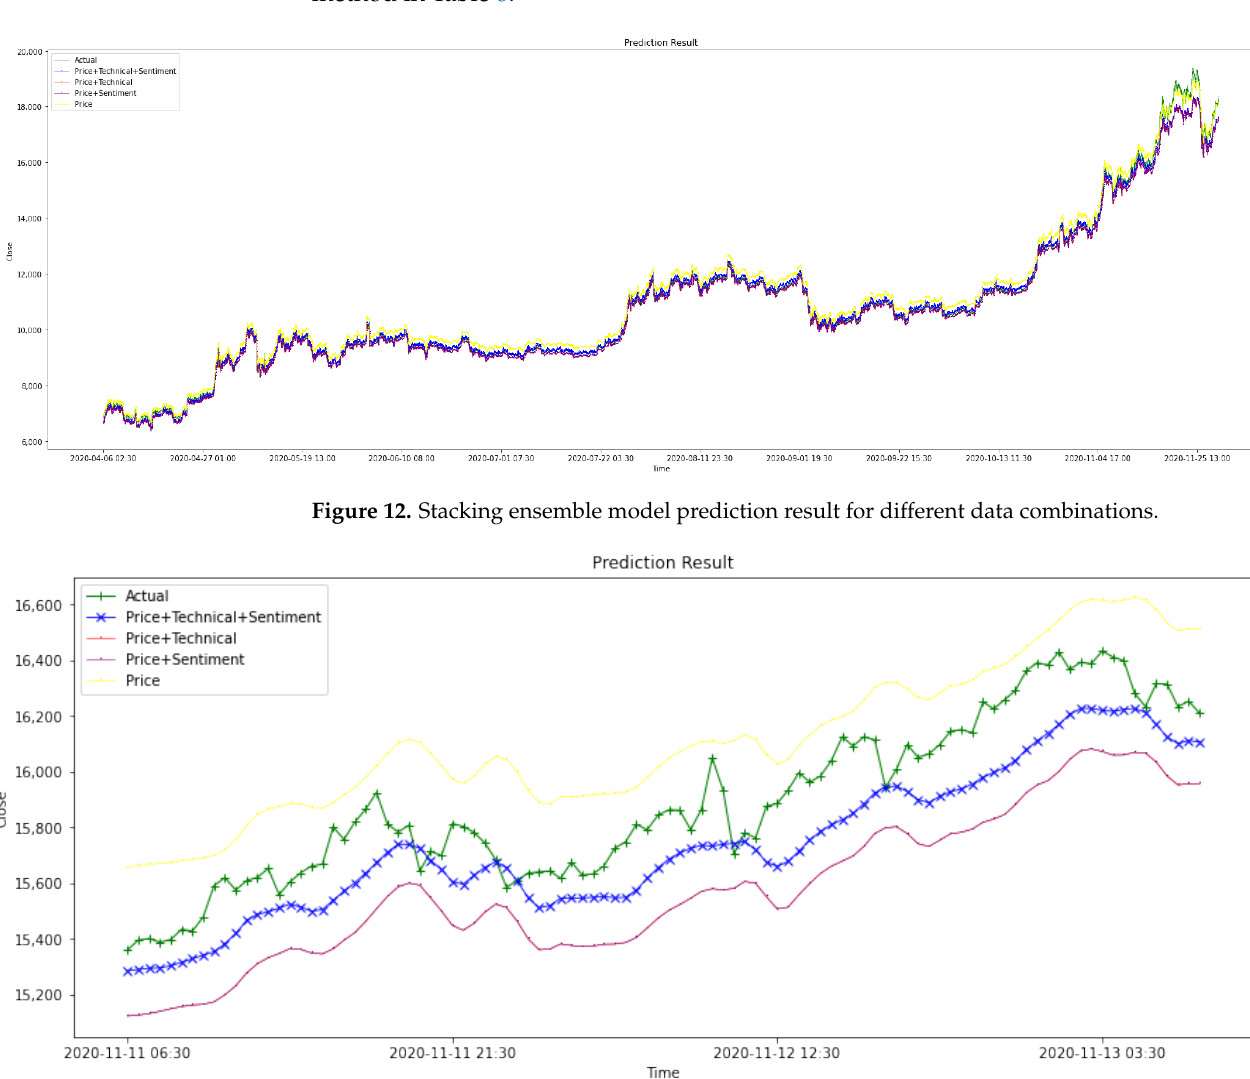
Figure 13. Stacking ensemble model prediction result for different data combinations from